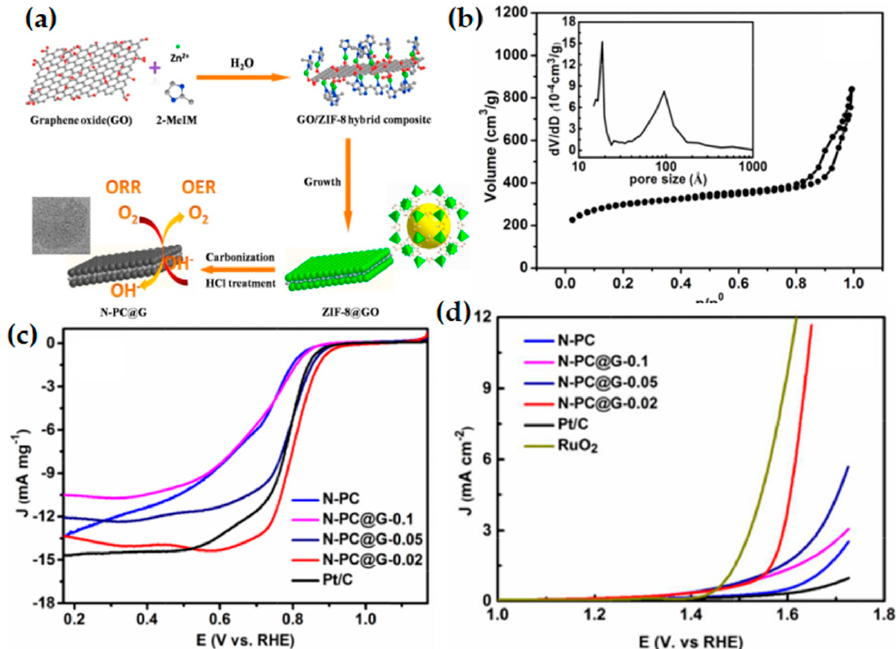
Figure 15. ( a ) Schematic illustration of a synthetic process of sandwich-like structured N-doped porous carbon@graphene (N-PC@G); ( b ) N 2 sorption–desorption isotherm of the N-PC@G-0.02 sample; the inset of the corresponding pore-size distribution; ( c ) LSV curves of ZIF-8 derived carbon and commercial Pt/C catalysts in O 2 -saturated 0.1 M KOH solution at a scan rate of 10 mV s − 1 and a rotating rate of 1600 rpm; ( d ) OER polarization currents of ZIF-8 derived carbon, RuO 2 and Pt/C electrodes in 0.1 M KOH solution at a scan rate of 10 mV s − 1 . Copyright 2016 Elsevier Ltd. All